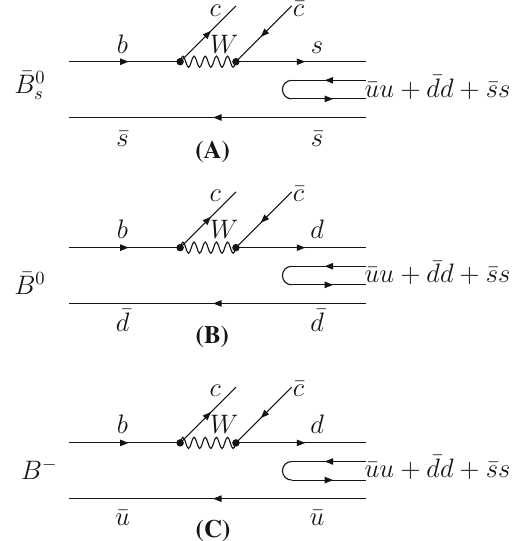
Fig. 1 Diagrams for the decay of ¯ B 0 , ¯ B 0 s and B − into η c ( c ¯ c ) and a primary q ¯ q pair, s ¯ s for ¯ B 0 s ( a ), d ¯ d for ¯ B 0 ( b ), and d ¯ u for B − ( c ). The schematic representation of the hadronization ¯ qq → ¯ qq ( ¯ uu + ¯ dd + ¯ ss ) is also